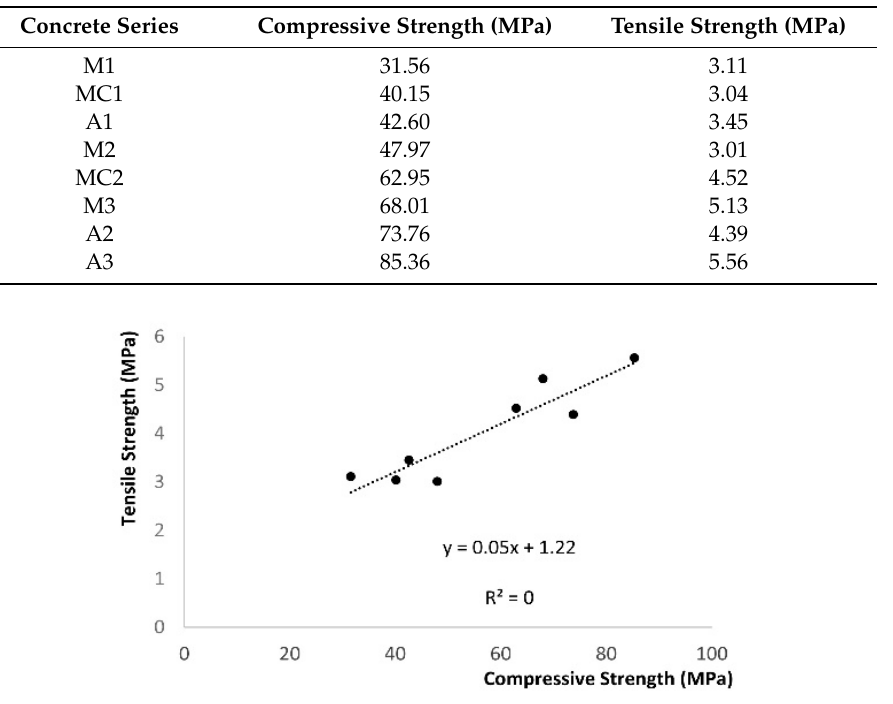
Figure 5. Relationship between compressive and tensile strengths for concrete series presented in Table 1.